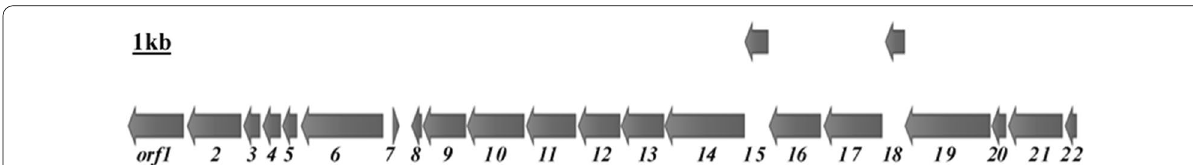
Fig. 6 Physical map of the complete toluene 4-monooxygenase (T4MO) and the first phenol-2-hydroxylase (I. P2H) encoding gene clusters followed by genes involved in the “lower”-pathway of toluene/ p -xylene metabolism. The putative functions of enzymes encoded by the genes were predicted as follows: orf1 T4MO subunit tmoF , orf2 T4MO subunit tmoE , orf3 T4MO subunit tmoD , orf4 T4MO subunit tmoC , orf5 T4MO subunit tmoB , orf6 T4MO subunit tmoA ; orf7 hypothetical protein, orf8 2-hydroxy-muconate tautomerase, orf9 4-oxalocrotonate decarboxylase, orf10 2-hydroxy-2-oxovalerate aldolase, orf11 acetaldehyde-CoA dehydrogenase, orf12 oxidoreductase, short chain dehydrogenase, orf13 2-keto-4-pentenoate hydratase , orf14 2-hydroxymuconic semialdehyde dehydrogenase, orf15 uncharacterized protein, orf16 catechol 2,3-dioxygenase ( xylE ), orf17 P2H P5 protein ( dmpP ), orf18 P2H P4 protein ( dmpO ), orf19 P2H P3 protein ( dmpN ), orf20 P2H P2 protein ( dmpM ), orf21 P2H P1 protein ( dmpL ), orf22 P2H P0 protein ( dmpK